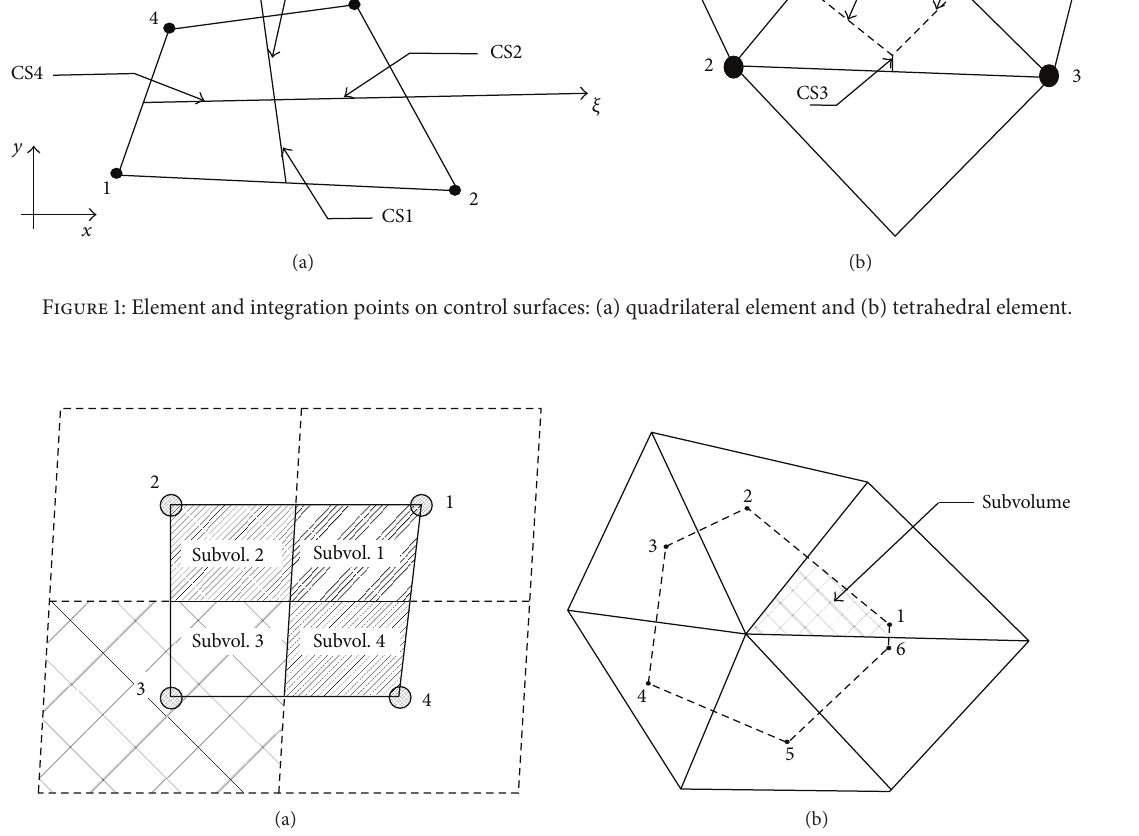
Figure 2: Subvolumes of elements: (a) quadrilateral element and (b) tetrahedral element.